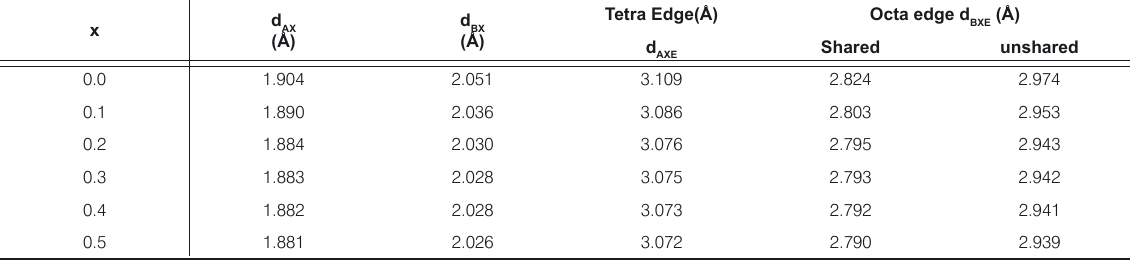
Table 2. Tetrahedral bond (d (± 0.002 Å).